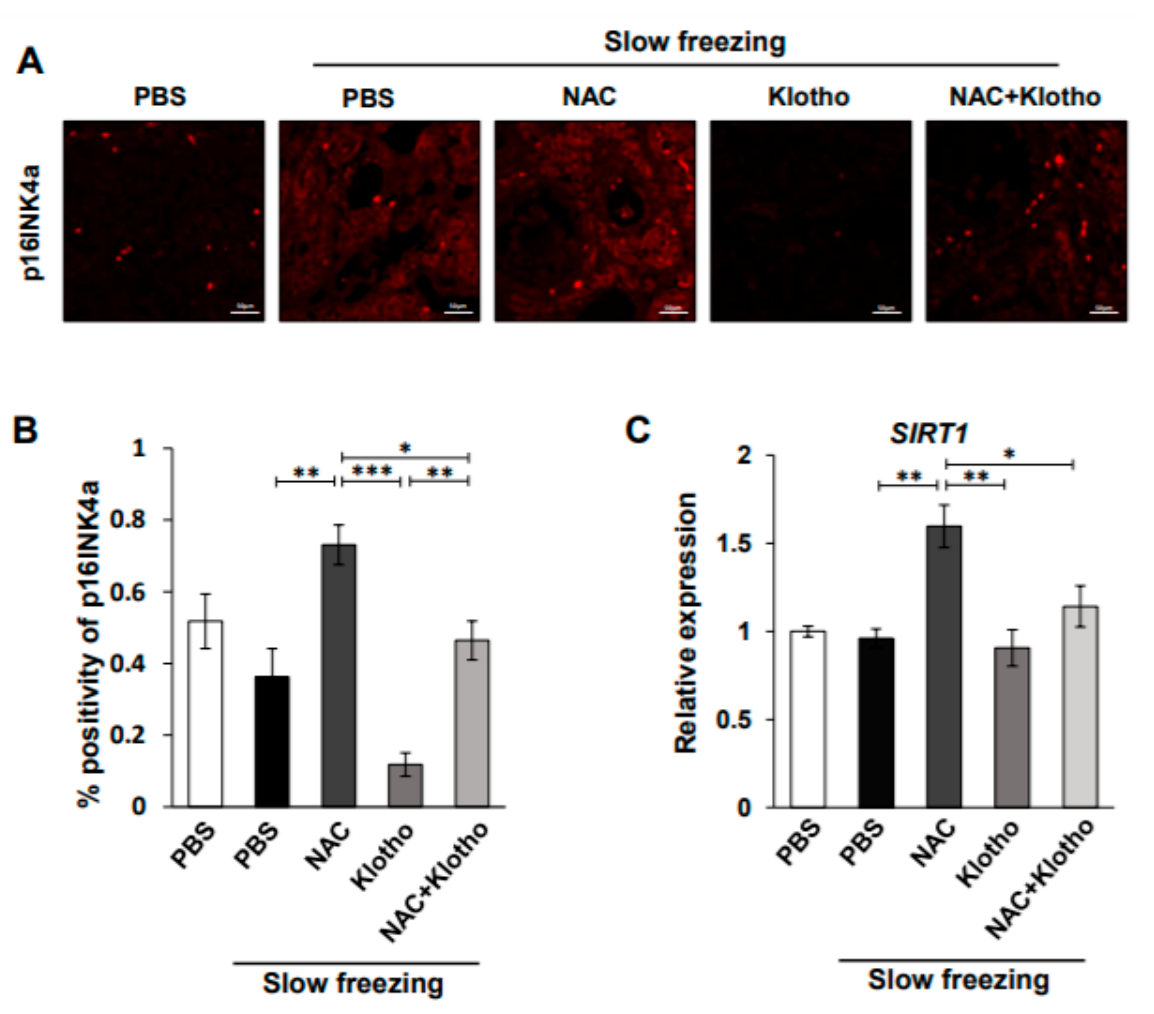
Figure 3. Klotho protein protects NAC-induced senescence in ovarian tissue. ( A , B ) Representative IF images at 400 × magnification of ovarian tissues with p16INK4a. The positive area for those receptors is shown as red. ( B ) Percentage of p16INK4a-positive cells. ( C ) qPCR of SIRT1 genes in ovarian tissue after cryopreservation. All data are shown as mean ± SD. The p values were determined by one-way ANOVA. * p < 0.05; ** p < 0.01; *** p < 0.001. n = 6 each group. Each experiment was repeated three times.